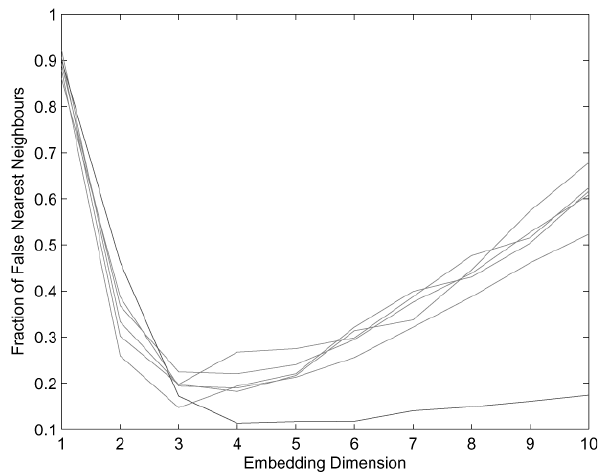
Fig. 13. The plots comparing the fraction of false nearest neighbors plotted against the embedding dimension for the original detrended data (blue curve) with the mutual information for 5 surrogate data (red curves) for TEC data measured at Lagos for the quietest day of March